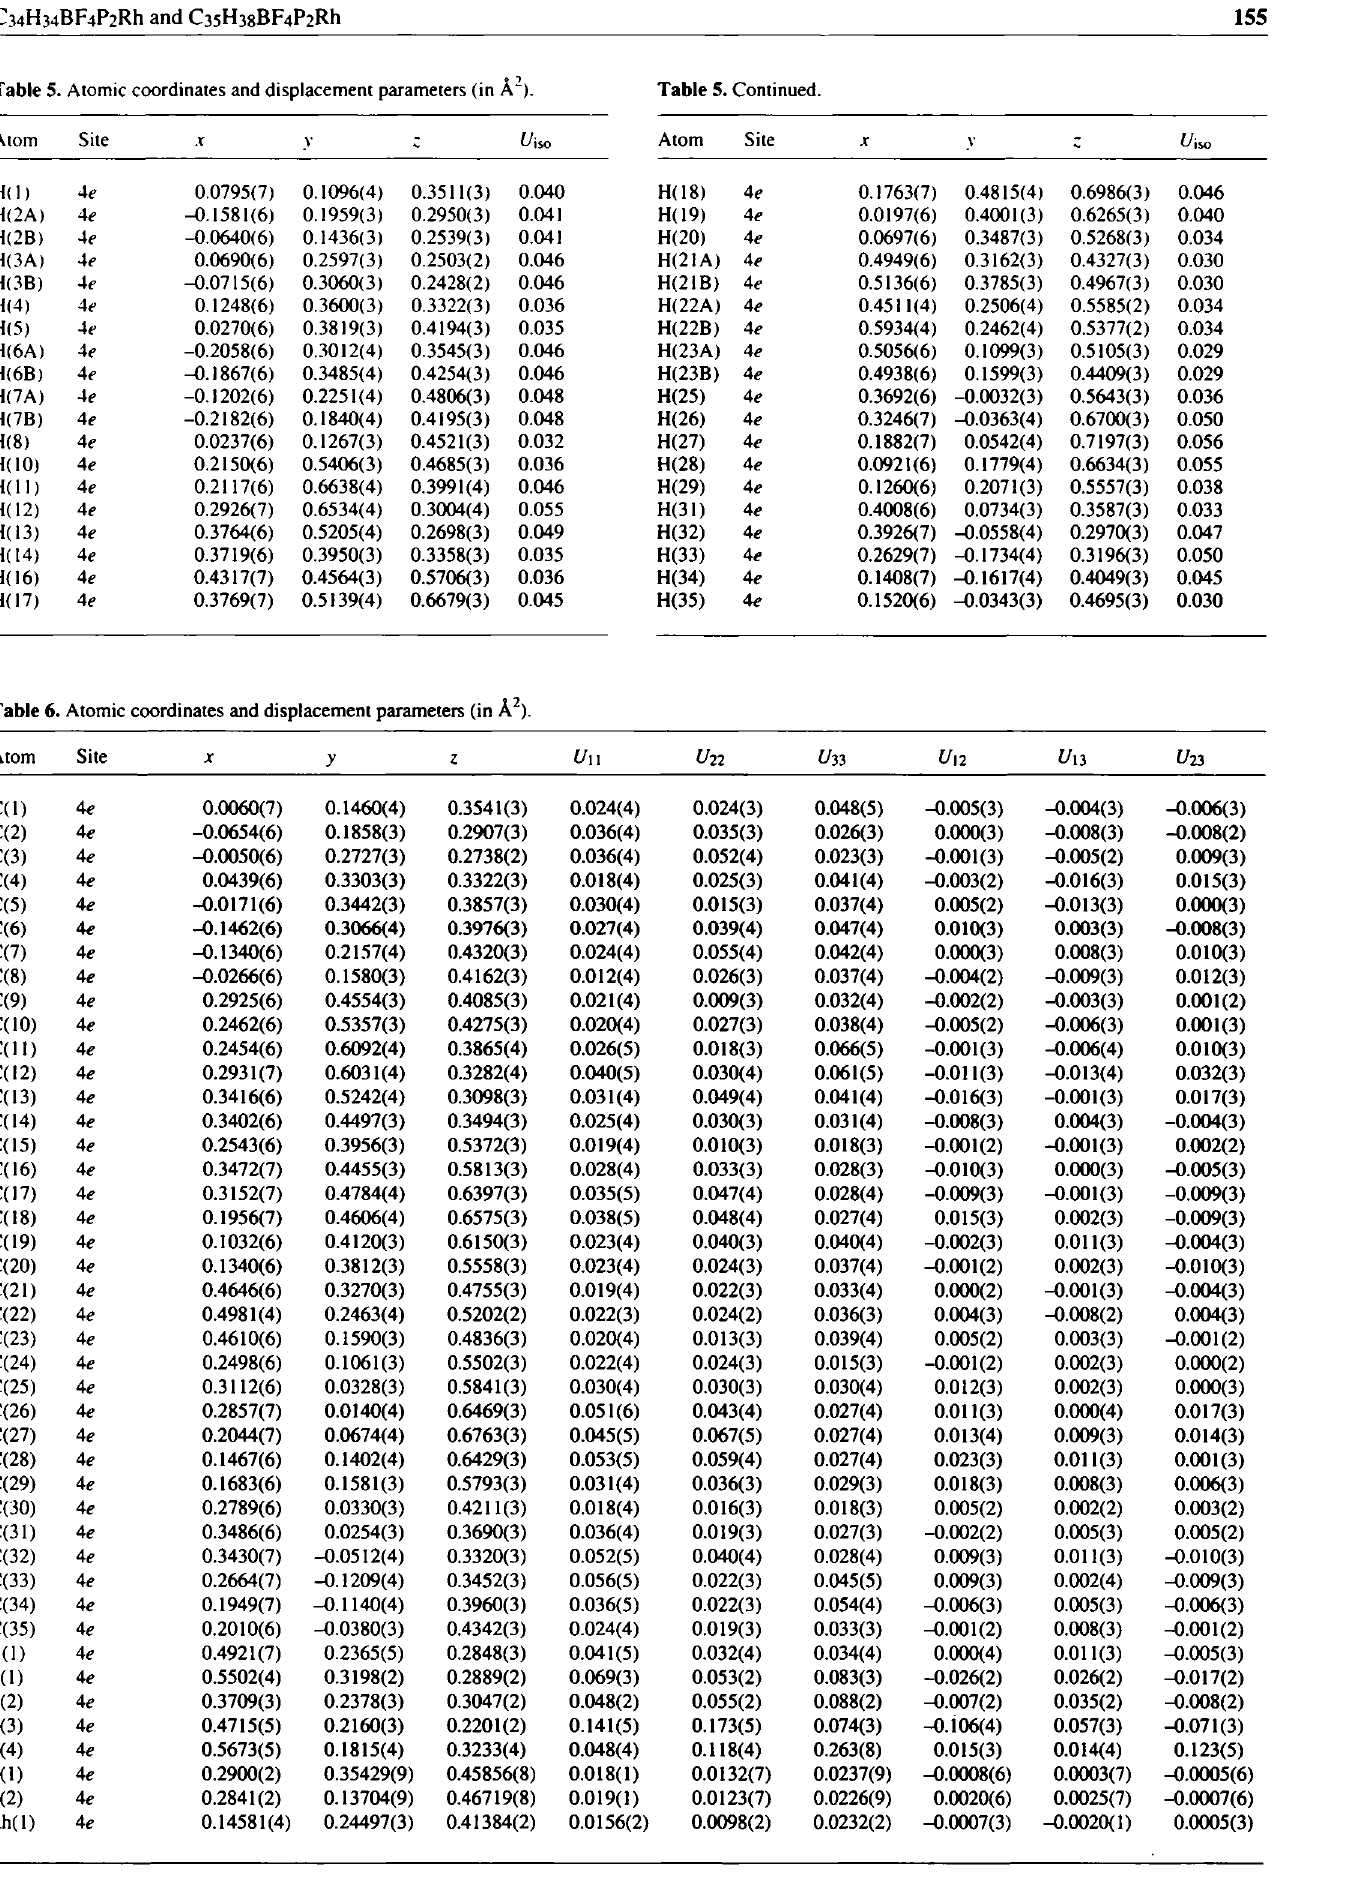
Table 5. Atomic coordinates and displacement parameters (in Ä 2 ).